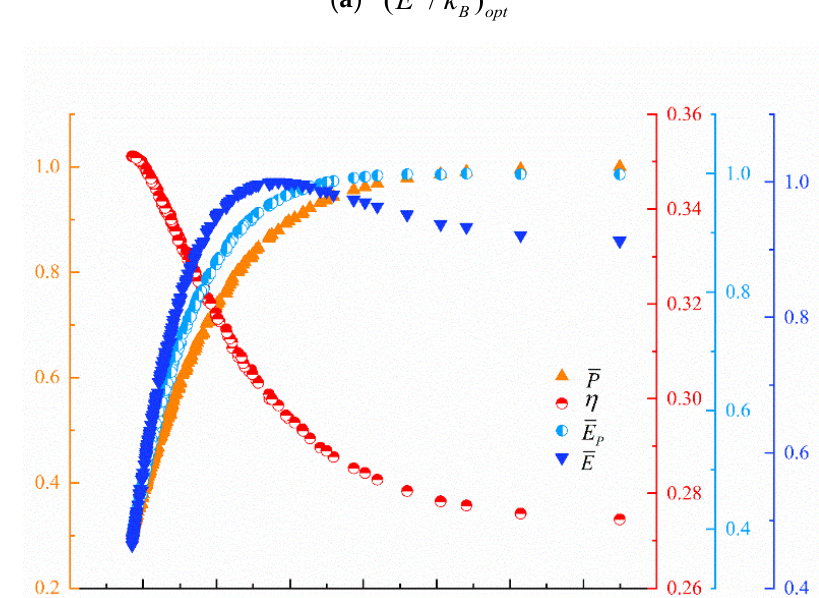
Figure 4. Distributions of ( E (cid:48) / k B )